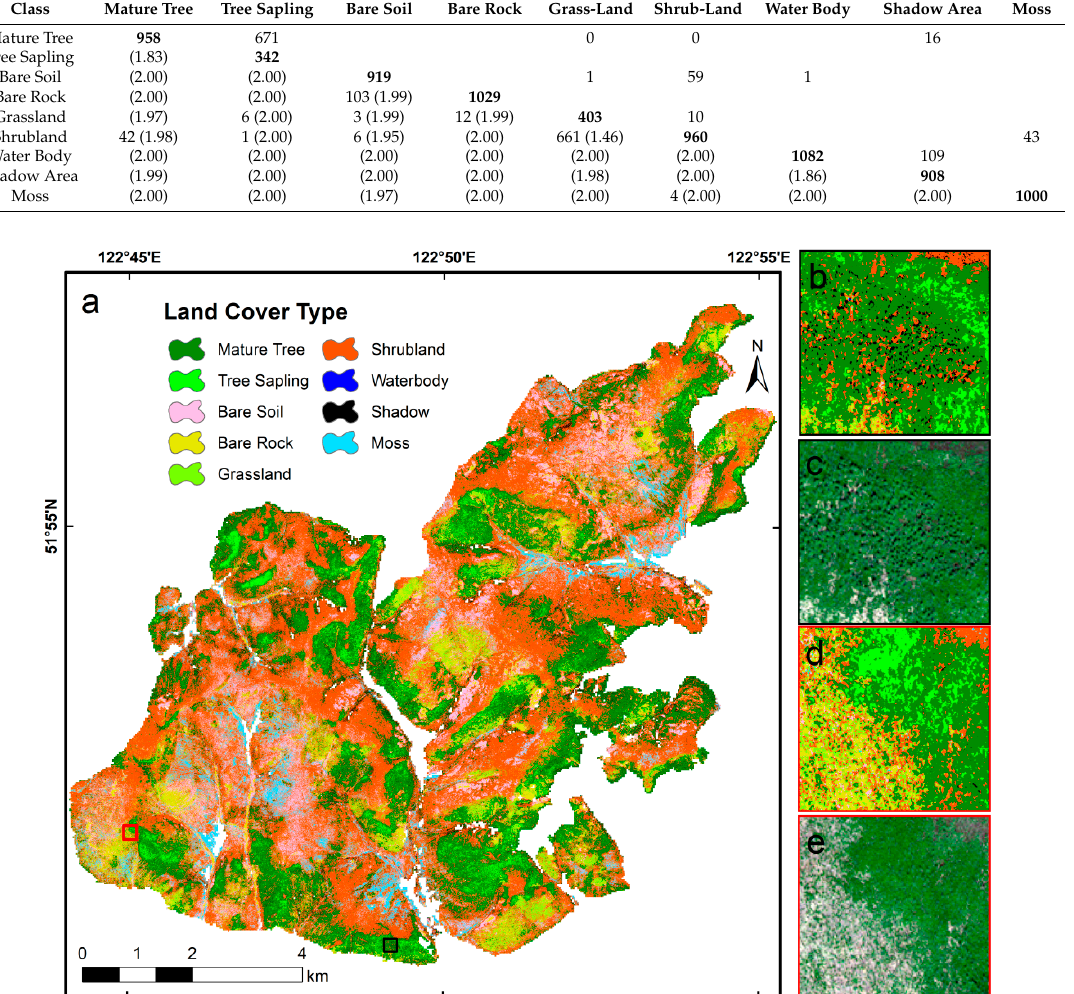
Table 4. Pairwise Jeffries–Matusita distance (JMD, values within brackets) and confusion matrix for evaluating intra-classes separability and classification accuracies respectively. The bold represents the number of verified samples.